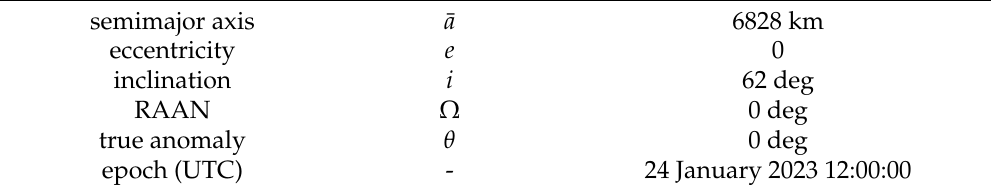
Table 13. Guidance strategy: orbit parameters of target